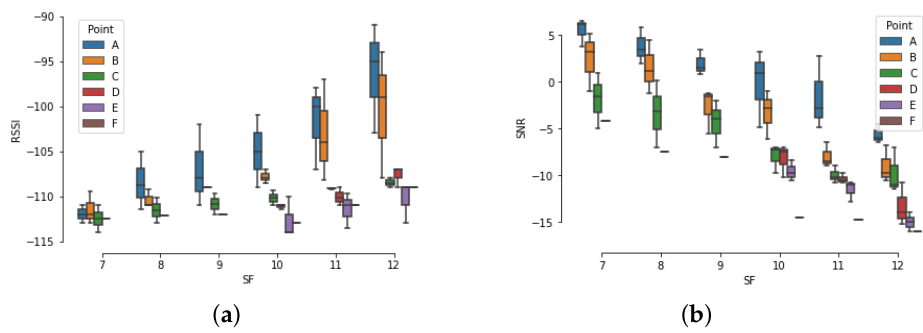
Figure 33. Average RSSI and SNR per point and SF LoRaWAN. ( a ) RSSI. ( b ) SNR.